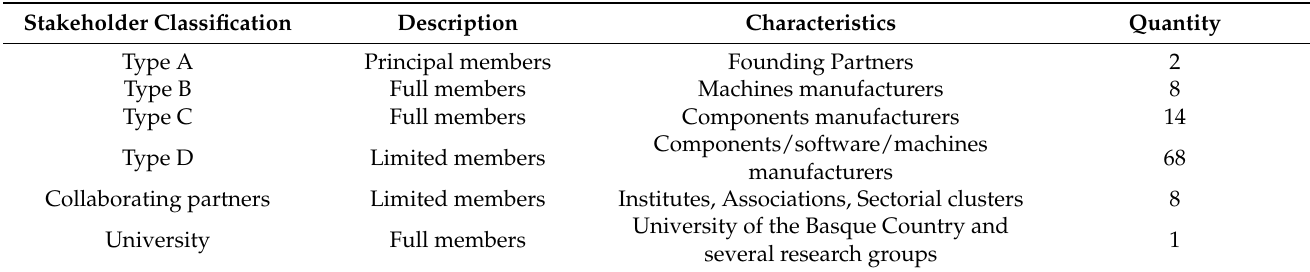
Table 5. The CFAA’s Internal